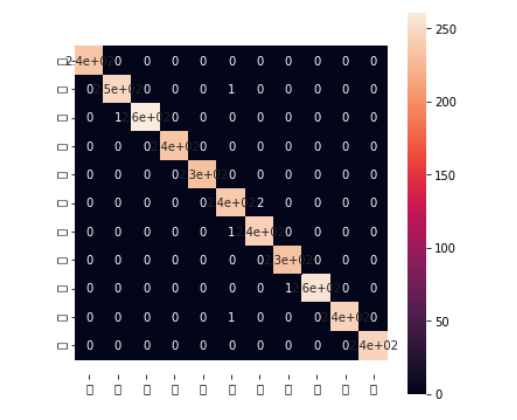
Figure 16. Confusion